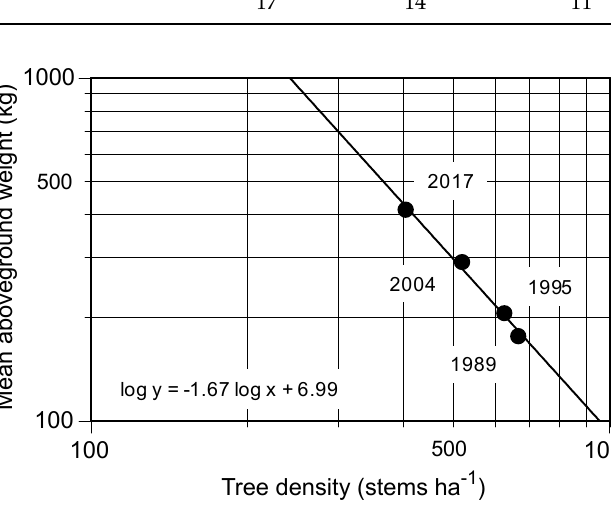
Figure 3. Relationships between tree density (stems ha − 1 ) and mean aboveground weight (kg) of Castanopsis cuspidata in the permanent plot during the study period. The number shows the measuring year of the forest biomass.